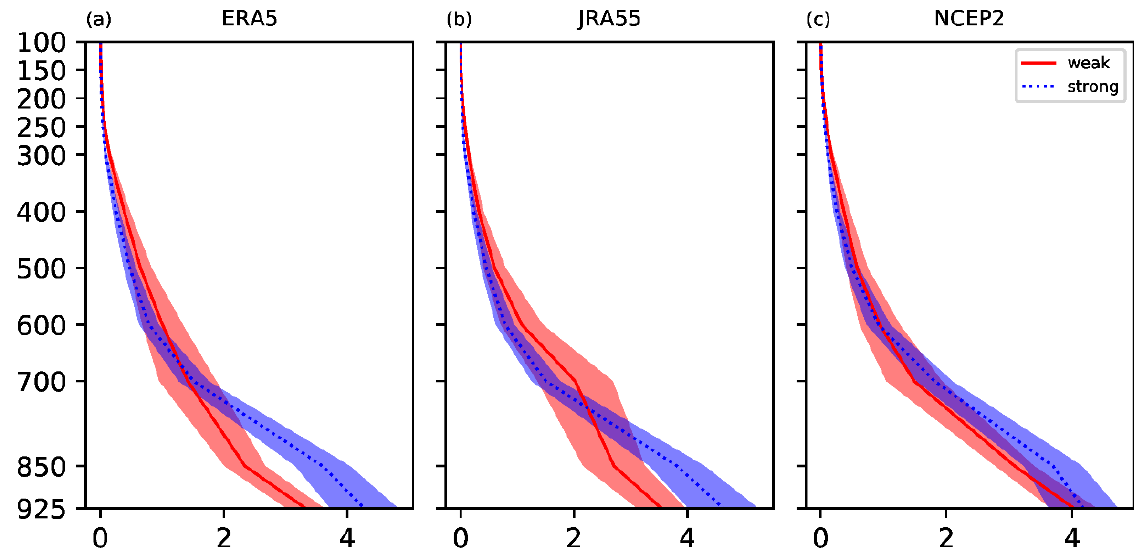
Figure 2. The vertical profiles of specific humidity in strong and weak correlation continental areas. (unit: g · kg − 1 ). The shaded areas are the range of one standard deviation. ( a ) ERA5 datasets, ( b ) JRA55 datasets, and ( c ) NCEP2 datasets. The specific areas chosen are squared in Figure 1, Figures S1 and S2, correspondingly (Figures S1 and S2 are in the Supplementary Materials). Because the land surface pressure is around 940 hPa, the lowest level shown is 925 hPa).